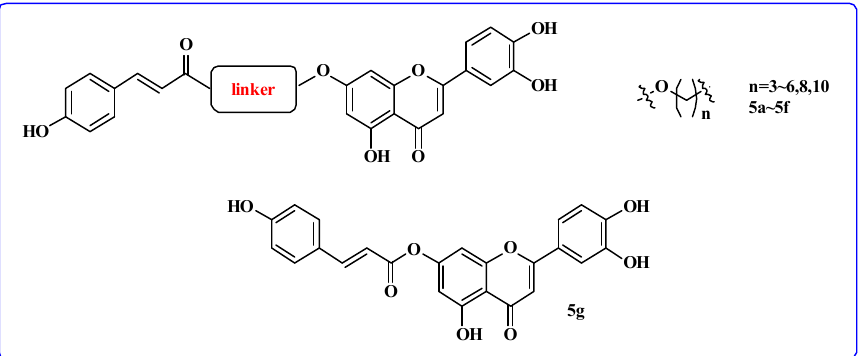
Figure 3. The design of Series Ⅱ compounds.